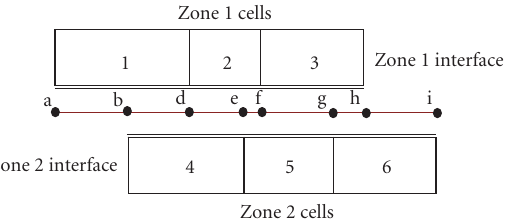
Figure 2: Sliding mesh and interior zone illustration.